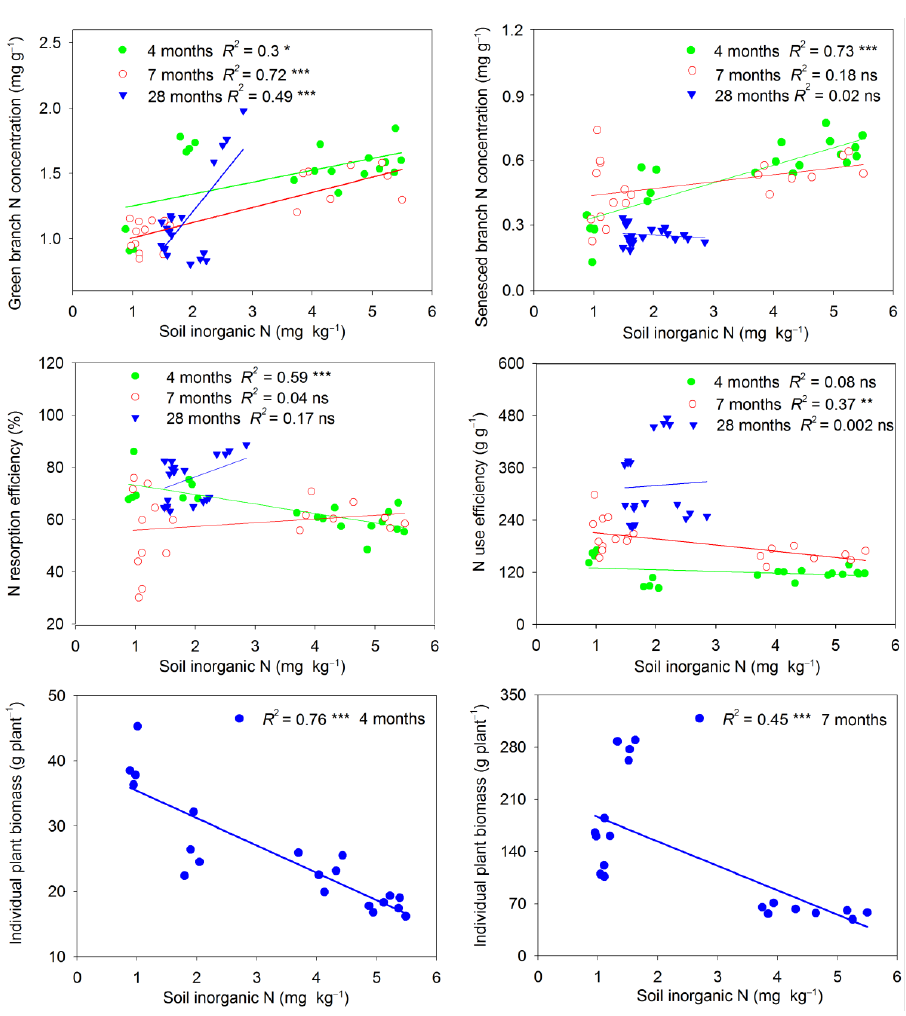
Figure 6. Relationships between N concentrations in green and senesced branches, N resorption efficiency, N use efficiency, individual plant biomass, and soil inorganic N. There was no correlation between soil inorganic N and individual plant biomass at 28 months old (R 2 = 0.01), and thus not displayed in the plots. Note: * p < 0.05; ** p < 0.01; *** p < 0.001; ns indicates no significant.